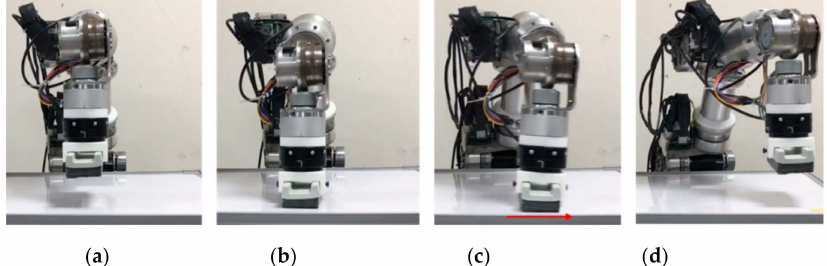
Figure 15. ( a ) Non-contact situation; ( b ) contact situation; ( c ) contact and force application; ( d ) and contact